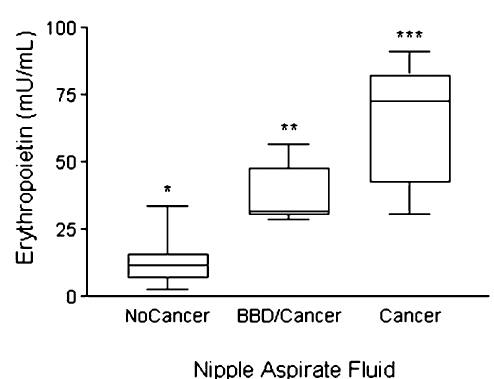
Fig. 2. Median erythropoietin levels in NAF of post-menopausal breast cancer patients ( N = 21) and NoCancer ( N = 42) women ( P < 0 .